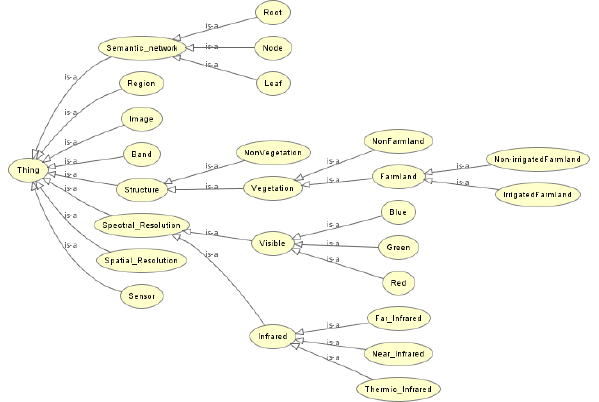
Figure 7 Farmland semantic network model in the ontology